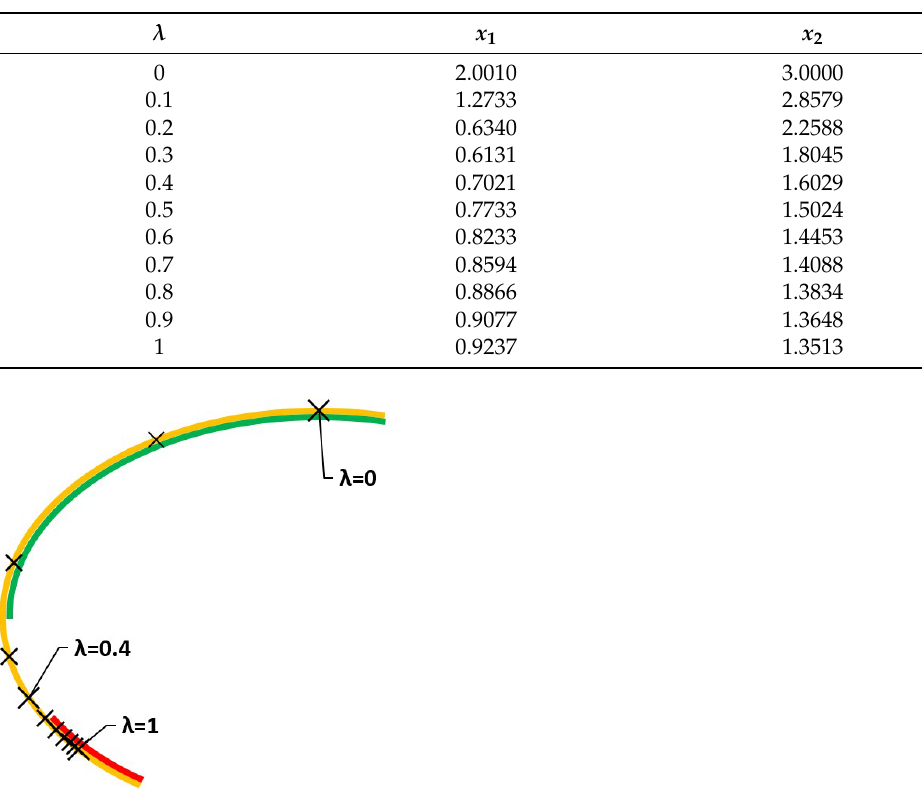
Figure 3. Solutions using the weighted sums method and efficient